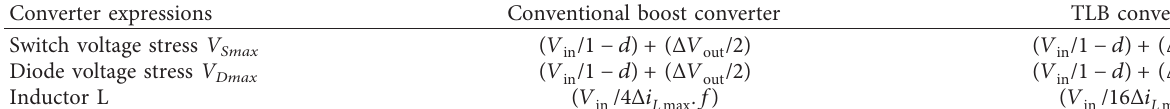
Table 2: Comparative expressions between TLB and boost converters.